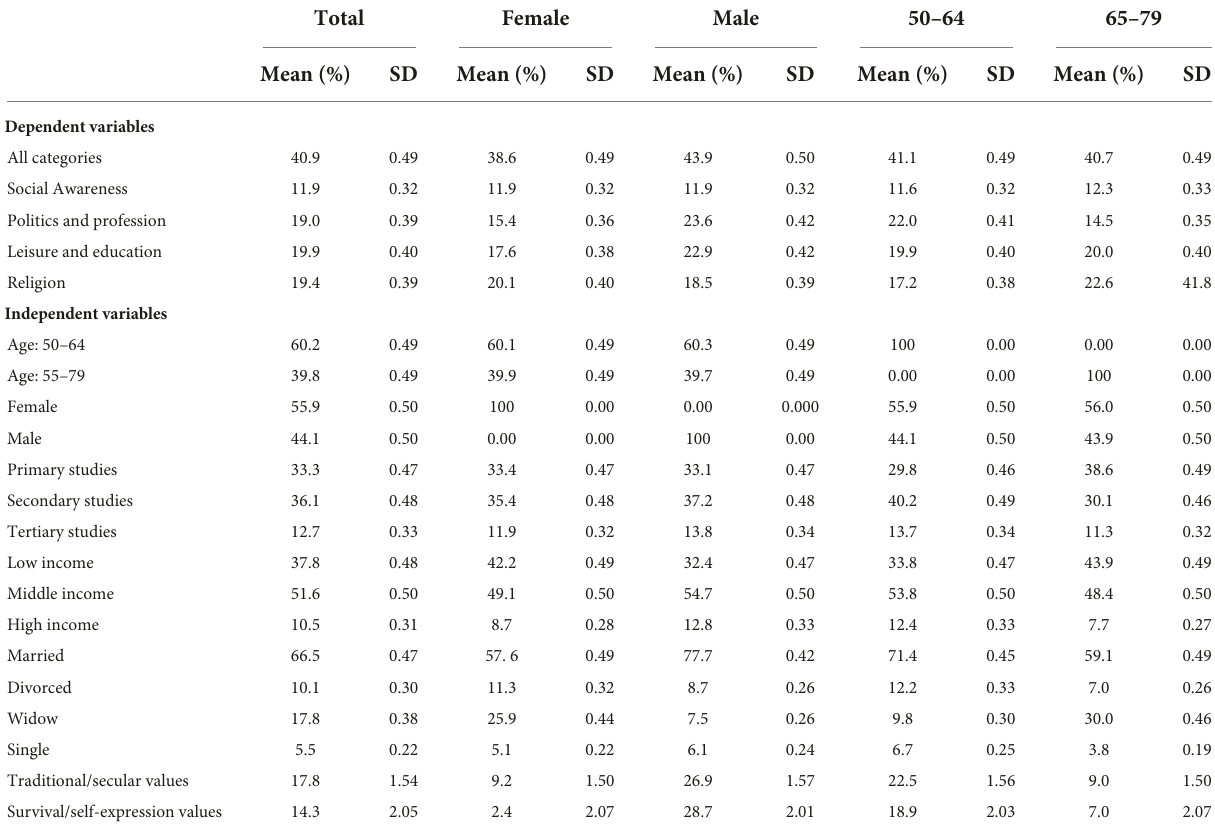
TABLE 1 Variables (means and standard deviation by gender and